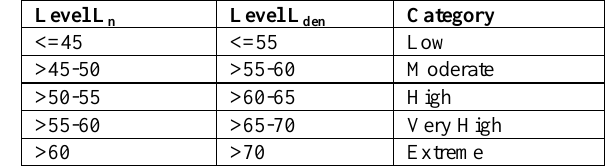
Table 2. Reclassification of noise levels into